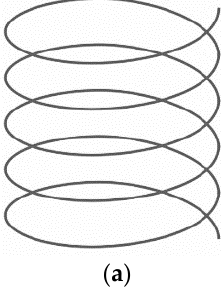
Figure 4. ( a ) Left helix, ( b ) co-pol and ( c ) cross-pol polarimetric signatures characterizing scattering.